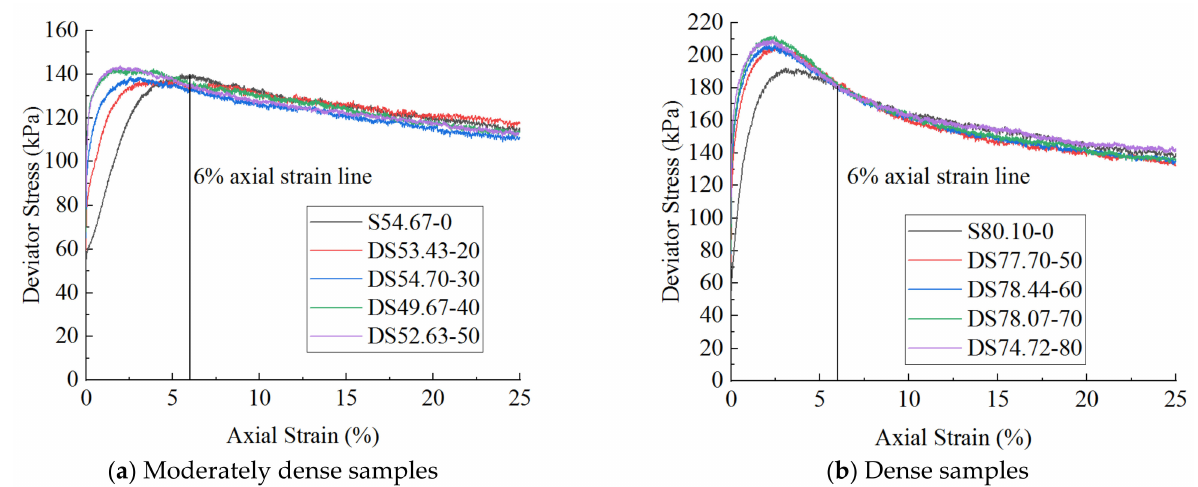
Figure 5. Deviatoric stress–strain relationship curves. Figure 6 indicates the peak strength S p all drained monotonic tests with cyclic loading. The linear growth in S p increasing relative density can be described by: